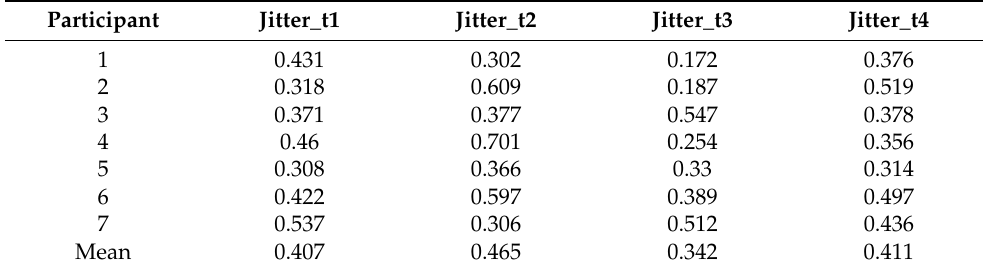
Table 9. Jitter (local, %) individual and mean measurements at four assessment time points.